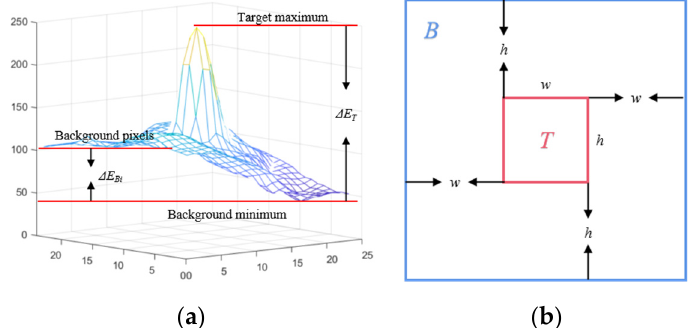
Figure 1. The calculation principle of LAGDM. ( a ) the mesh map of local area around the target, where Δ E T and Δ E B are the relative gray indexes of local area and target, respectively, which are defined in Equation (1) and Equation (2). ( b ) The schematic diagram of the local area around the target. Here, w and h are the width and height of the target area, respectively.